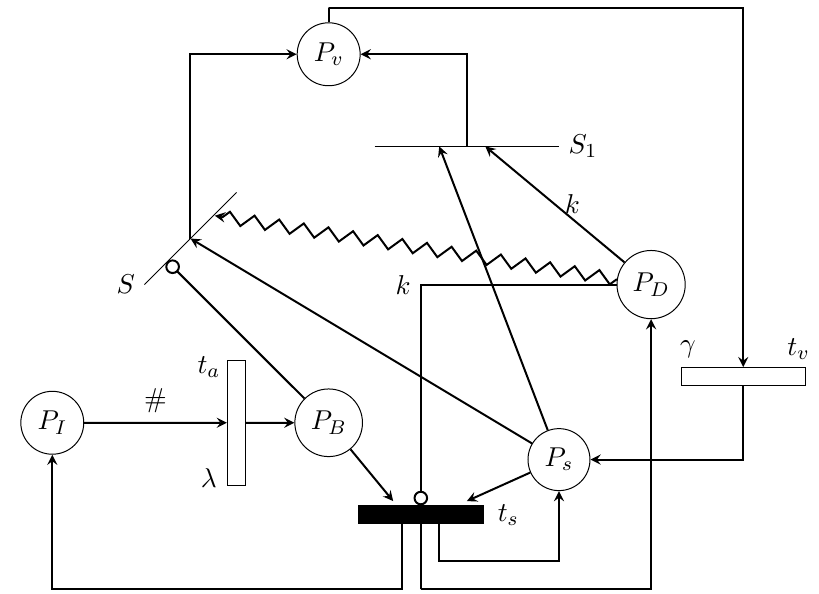
Figure 1: MRSPN model of the multiple vacation M/G/ 1 /N/V